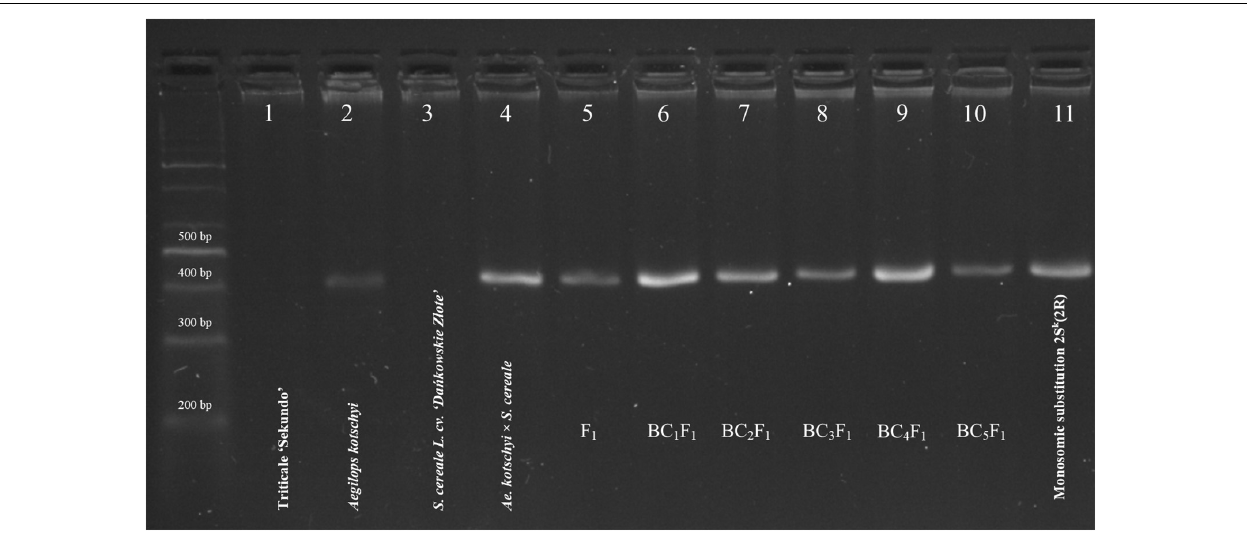
FIGURE 8 | Amplification products (410 bp) of S14-410 marker linked to loci of Lr54 + Lr37 leaf and stem rust resistance genes on 2S k chromosome of Ae. kotschyi . (1) triticale “Sekundo” (AABBRR); (2) Aegilops kotschyi (U k U k S k S k ); (3) Secale cereale L. “Dañkowskie Złote”; (4) Aegilops kotschyi × Secale cereale (2 n = 6 x = 42; UUMMRR); (5) F 1 ; (6) BC 1 F 1 ; (7) BC 2 F 1 ; (8) BC 3 F 1 ; (9) BC 4 F 1 ; (10) BC 5 F 1 ; and (11) monosomic 2S k (2R) substitution plant of triticale (2 n = 42). Size standard: Thermo Scientific TM GeneRuler TM 100 bp DNA